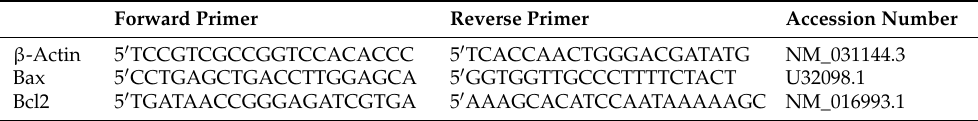
Table 1. Primer sequences for determination of β -Actin, Bax, and Bcl2 gene